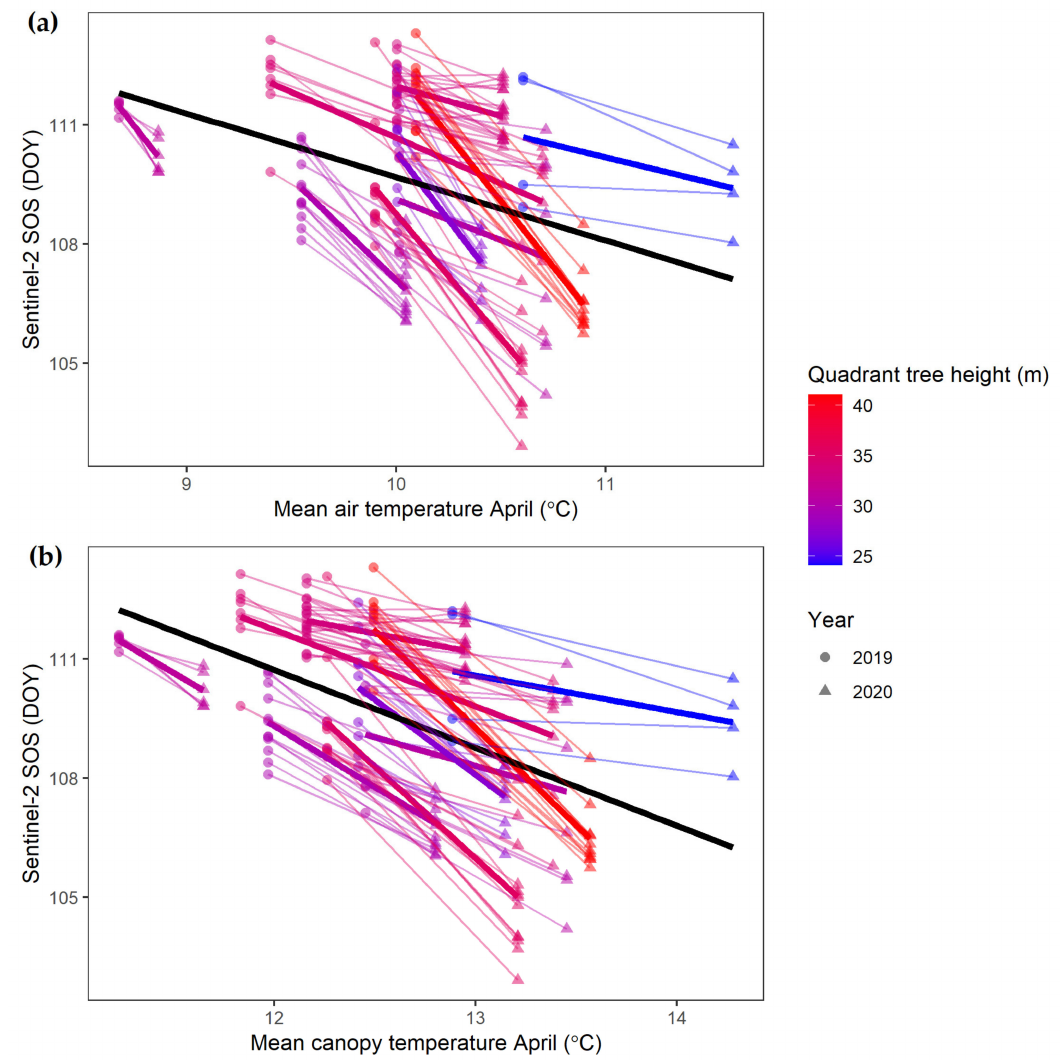
Figure 5. Interaction effects of climate variables (mean air temperature April ( a ), mean canopy temperature April ( b )) and tree height on Sentinel-2 SOS. Colors correspond to the mean tree height per quadrant. Circles represent observations from 2019, triangles represent observations from 2020. Same individuals are connected with thin lines. Thick colored lines connect the mean observation in 2019 with the mean observation in 2020 per quadrant. Thick black lines are linear regression